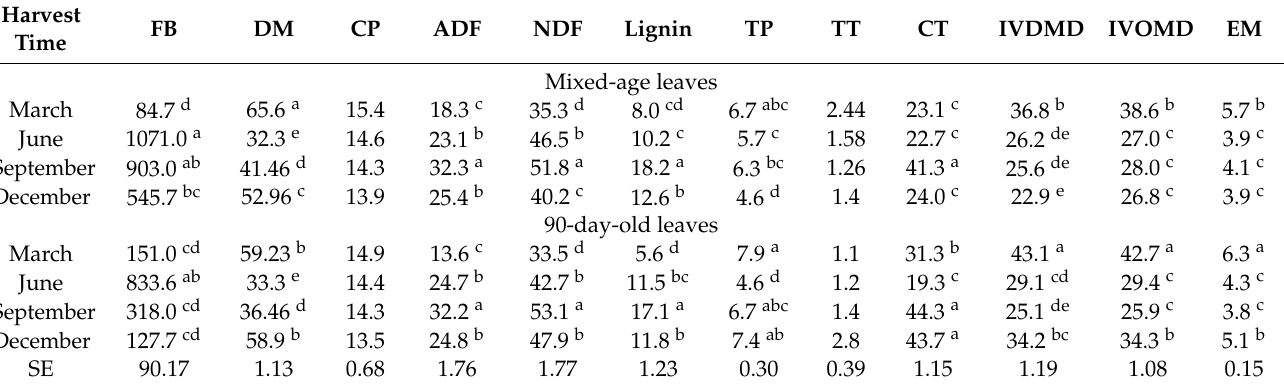
Table 1. Effect of month of harvest and leaf age on biomass production (g FB) and chemical com- position (%) of Gymnopodium floribundum leaves, including dry matter (DM), crude protein (CP), condensed tannins, in vitro dry matter digestibility (IVDMD), in vitro organic matter digestibility (IVOMD), and metabolizable energy (ME in MJ/kg